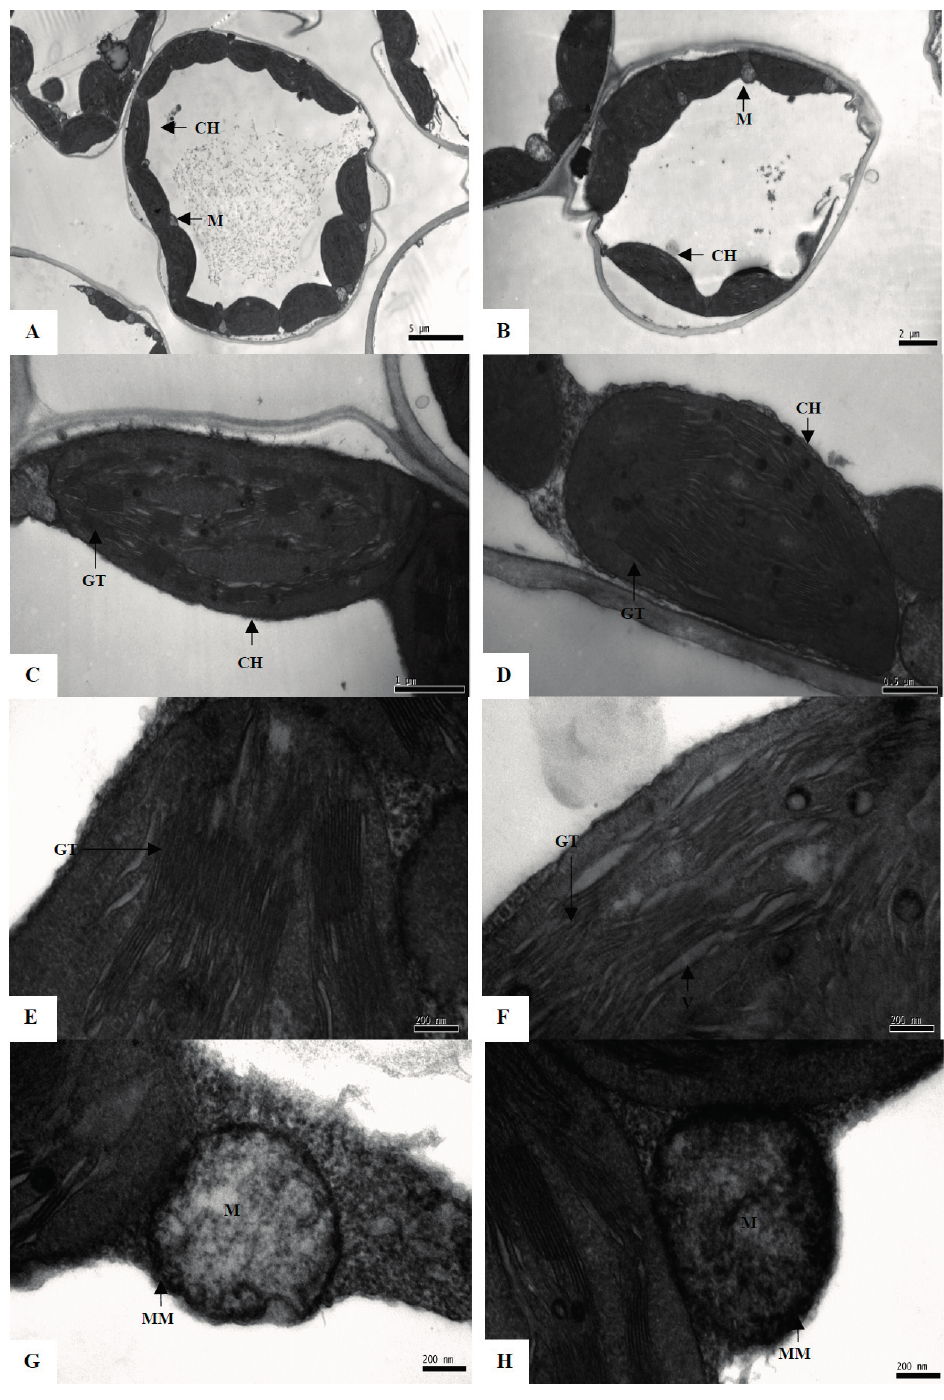
Figure 3. Transmission electron micrographs of the leaf sections of maize seedlings between control (control) ( A , C , E and G ) and 20% PEG-stimulated water deficiency treatment ( B , D , F and H ) for two